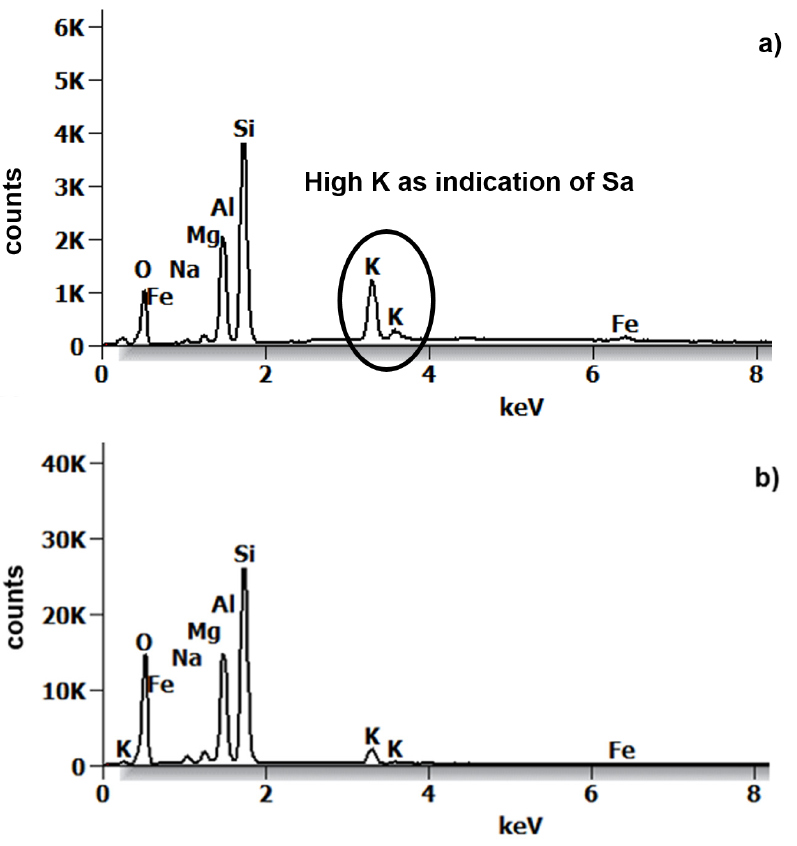
Figure 7. Two Energy dispersive X-ray spectroscopy spectra acquired from sample 04MRE123 extracted fraction. Analyses correspond to the position 1 and 2 shown in Figure 6a. ( a ) The spectrum 1 indicates sanidine based on the peak ratios and a higher K peak. ( b ) The spectrum can be assigned to a clay phase (very low K intensity), in our case interlayered I/S based on the mineralogy, morphology and chemistry.